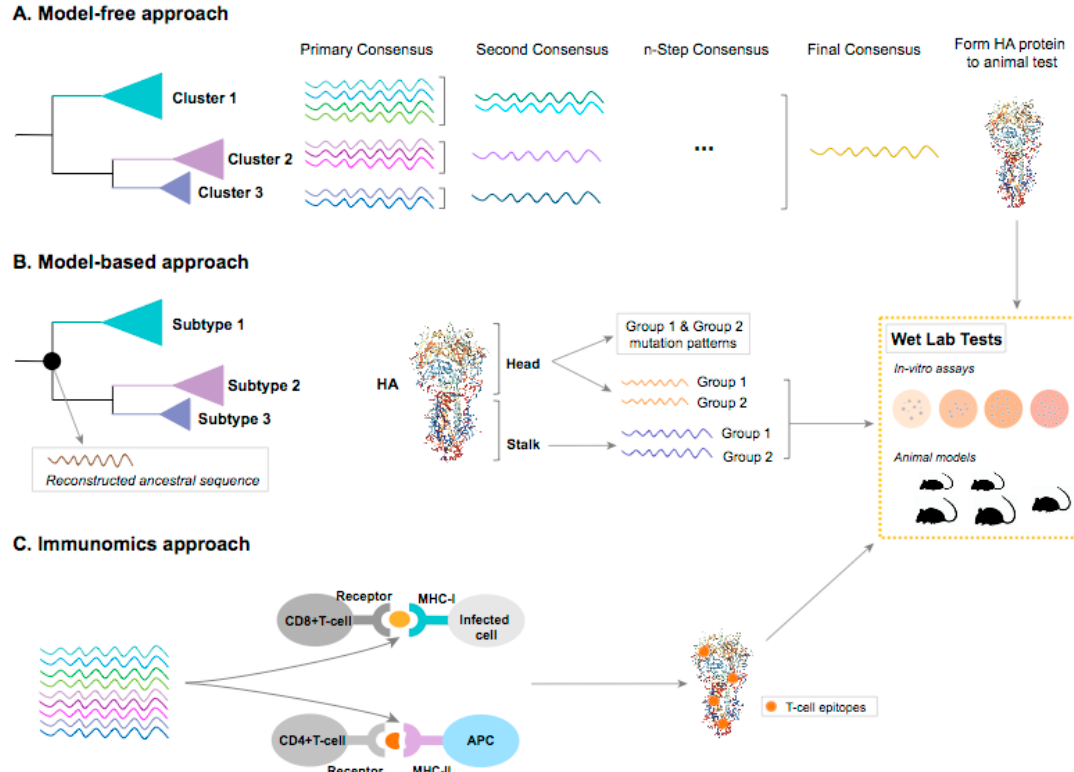
Figure 2. Framework for computational influenza universal vaccine design. ( A ) Model-free consensus-based optimized approach. Consensus sequences from previously defined clusters are generated by aligning and comparing multiple sequences and selecting the most common residue at each position. It may go through several steps until the generation of a final consensus. ( B ) Model-based ancestral sequence reconstruction approach. Maximum likelihood and Bayesian approaches are the most commonly used statistical phylogenetic methods to reconstruct ancestral sequence at the ancestral node (shown as black dot on the tree) [46–48]. Evolutionary models that incorporate protein structural domains can be used to separately estimate the evolutionary history on each functional partition as the HA head and stalk domains. Based on the evolutionary relationship among di ff erent subtypes of influenza A virus, common ancestral sequences of head and stalk domains can be generated within influenza A virus Group 1 (H1, H2, H5, H6, H7, H8, H9, H11, H12, H13, H16, H17, and H18) and within Group 2 (H3, H4, H7, H10, H14, and H15), respectively. ( C ) Immunomics approach. The T-cell epitope prediction tools can be used to identify the potential CD4 + T-cell and CD8 + T-cell epitopes from the pathogen proteome or protein(s) based on the high binding a ffi nity between epitope-Major Histocompatibility Complex (MHC) complex. Some epitopes will be presented by the MHC-I on the surface of infected cells or by MHC-II on the surface of antigen presenting cells (APC) to the host CD8 + or CD4 + T-cells, respectively. These processes elicit the cellular and / or humoral immunity. The predicted T-cell epitopes that are evolutionarily conserved and common across or within subtypes will be constructed into peptides or proteins. All outputs from these three approaches, like epitopes, peptides, proteins or virus-like particles (VLPs), will be tested at in-vitro and / or in-vivo models to evaluate their immunogenicity. The proposed concept as shown is based on HA gene sequences, but these approaches should be used for all the gene segments of influenza viruses to generate a full profile of viral immunogenicity.